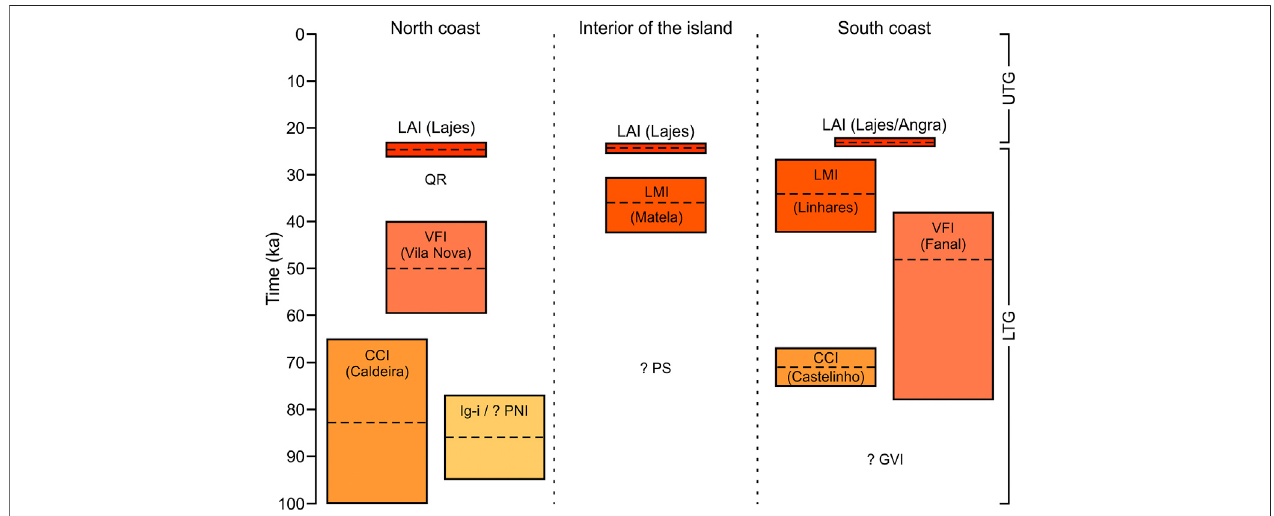
FIGURE2| CorrelationofignimbriteformationsonTerceira,showingaverageagesandmaximumerrorsforformationsfoundonthenorthandsouthcoastsandin the interior of the island. Ignimbrite members are given in parenthesis. Abbreviations: LAI — Lajes-Angra Ignimbrite; LMI — Linhares- Matela Ignimbrite; VFI — Vila Nova- Fanal Ignimbrite; CCI — Caldeira-Castelinho Ignimbrite; GVI — Grota do Vale Ignimbrite; PS — Posto Santo spatter- fl ow deposit; QR — Quatro Ribeiras pyroclastic fl ow deposit; Ig-i — Ignimbrite i; PNI — Pedras Negras Ignimbrite (adapted from Gertisser et al.,